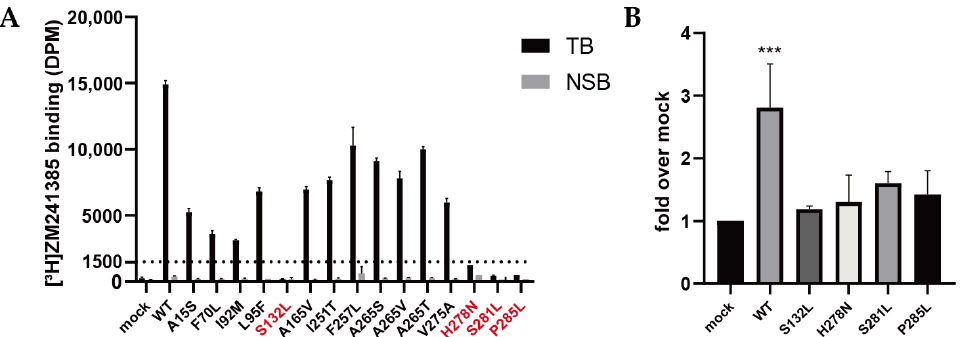
Figure 2. Radioligand binding and expression of wild-type and mutant A 2A ARs. ( A ) Radioligand binding of 2.5 nM [ 3 H]ZM241385 with 10 µg of membrane protein of HEK293T cells transiently transfected with wild-type or mutant A 2A AR. Specific binding was defined as the difference between total binding (TB) and non-specific binding (NSB). NSB was determined with 100 μM NECA as displacer. Data are shown as mean ± SD of two independent experiments performed in duplicate. ( B ) Expression levels of transiently transfected WT and mutant A 2A ARs on HEK293T-cell membrane, measured with an enzyme-linked immunosorbent assay. Mock values were measured with HEK293T cells transfected with a pcDNA3.1 empty vector as negative control. Data are shown as mean ± SD of two independent experiments performed in quintuplicate. (*** p < 0.001; ordinary one-way ANOVAs with Dunnett’s multiple comparisons tests; mock as control).